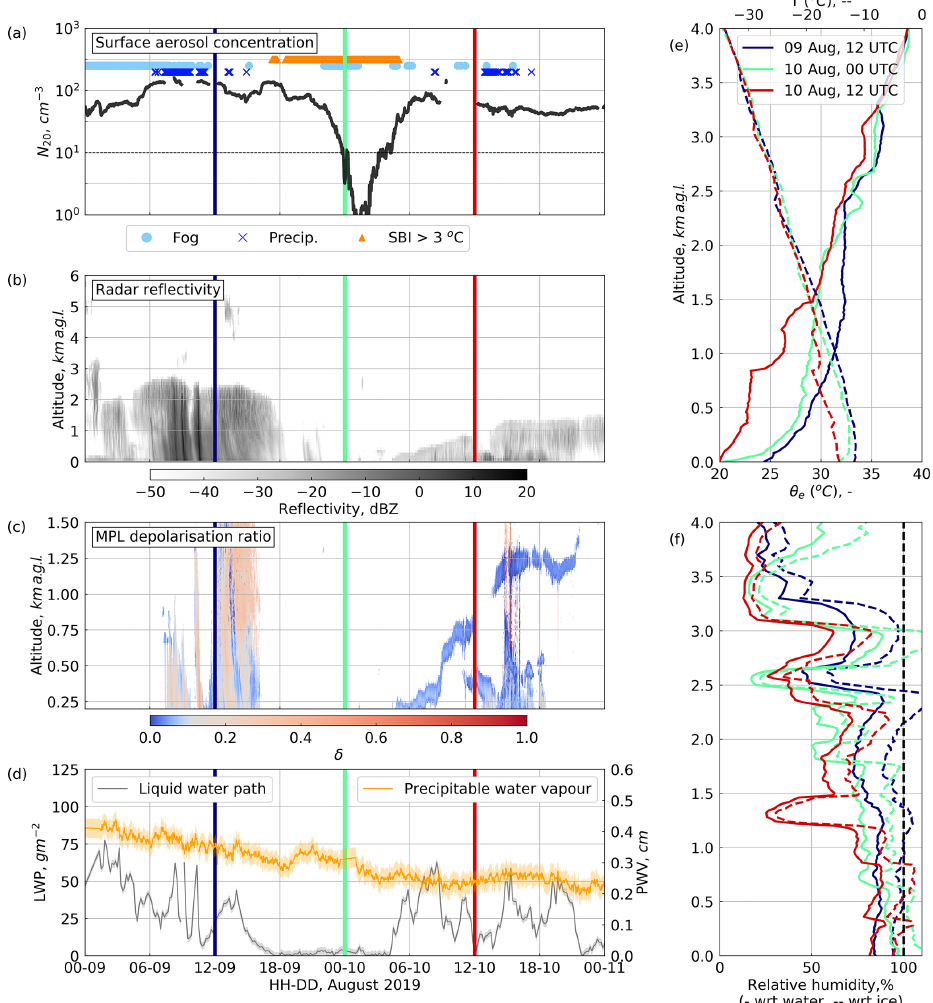
Figure 13. Same as Fig. 11 but during the 10 August 2019 low-aerosol case